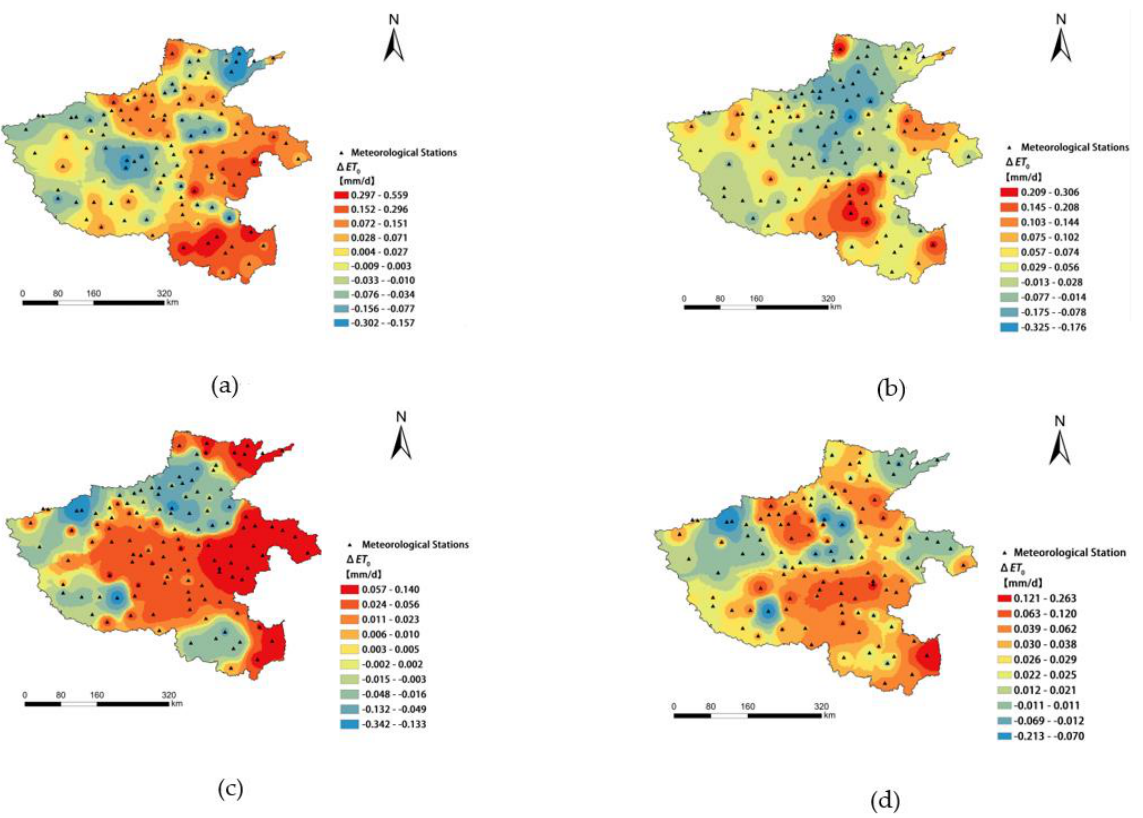
Figure 5. Effect of aerosols on ET 0 during daytime ( a , b ) and nighttime ( c , d ) for pollution ( a , c ) and good ( b , d ) air quality conditions.